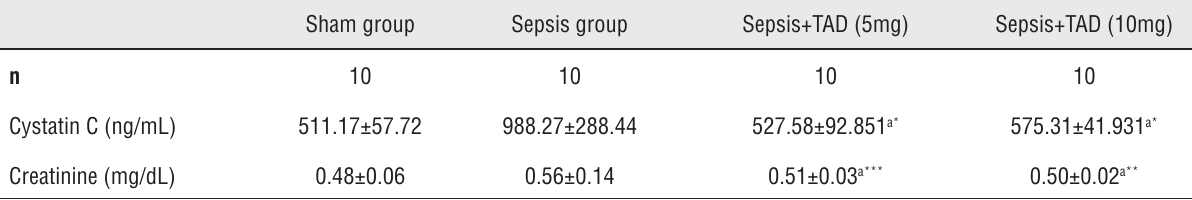
Table 4 - Effect of tadalafil on cystatin C and creatinine levels in rats serum with sepsis.